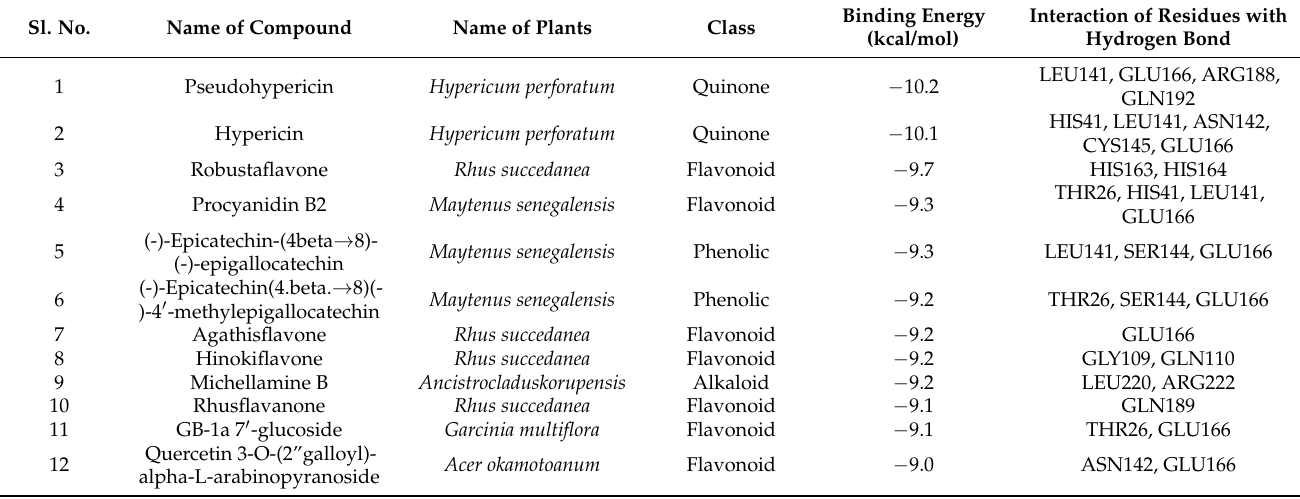
Table 1. Molecular docking results of the anti-HIV bioactive compounds against M pro of SARS-CoV-2. Sl.